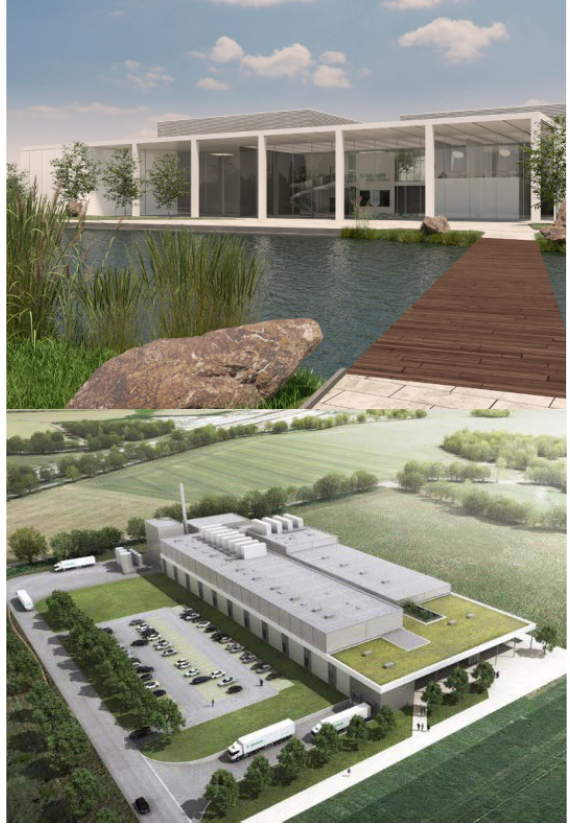
Fig. 4 Visualization of the new building of the filter factory Wilsdruff (Neugebauer and Rösch